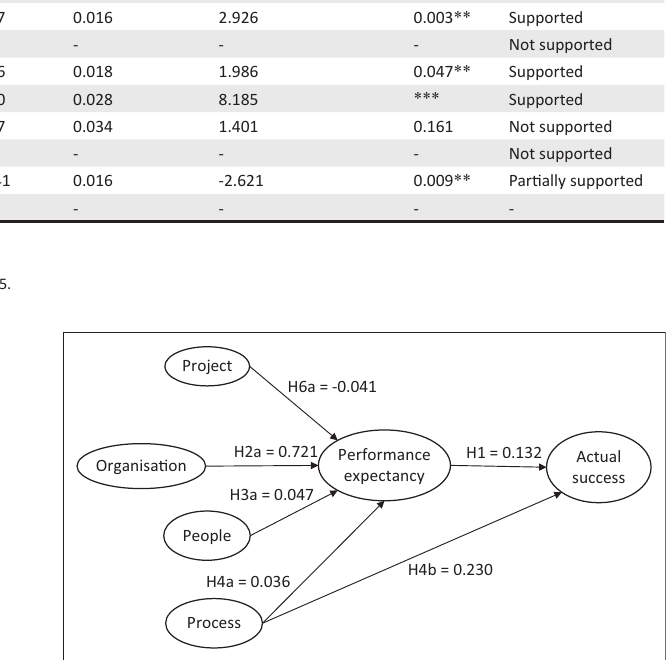
FIGURE 2: Structural equation for the final model.